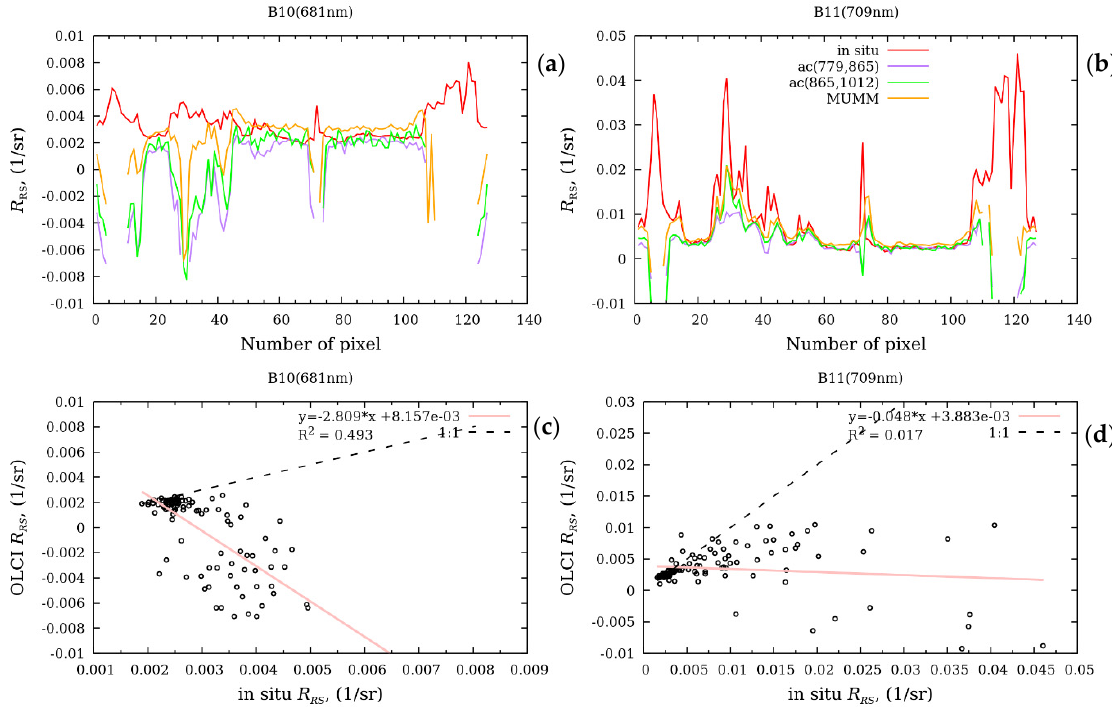
Figure 12. Validation results of R rs retrieved using various AC algorithms: in the B10(681) band ( a ); in the B11(709) band ( b ). MUMM (orange line), ac(779, 865) (purple line), ac(865, 1012) (green line), measurements (red line). The scatter plot of the R rs retrieved using ac(779, 865) and measured R rs in the B10(681) band ( c ), and in the B11(709) band ( d ). Line 1:1 (dotted line), linear regression (pink line). The number of match-ups is 127.